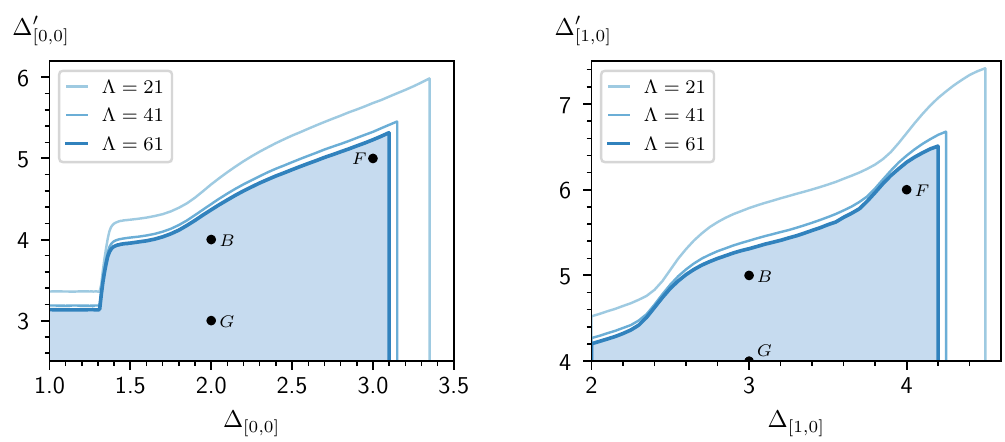
Figure 2 . Left: upper bounds on the dimension (cid:1) 0 function of the dimension (cid:1) There is a sudden jump in the upper bound for (cid:1) channel [1 ; 0], and we keep the operators slightly above the unitarity bound, i.e. (cid:1) Right: upper bounds on (cid:1) 0